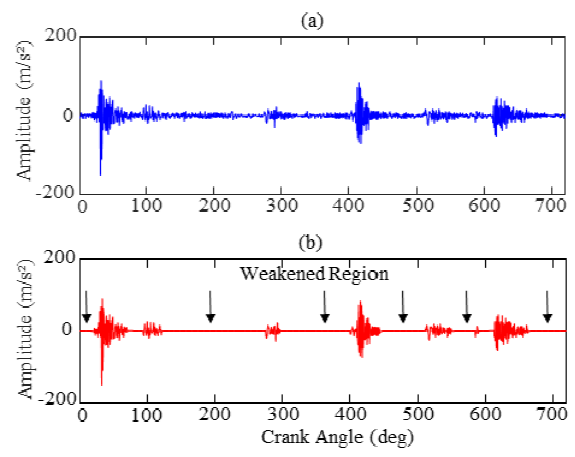
Figure 9. Comparison results of preprocessing: ( a ) original vibration signal; ( b ) processed signal.